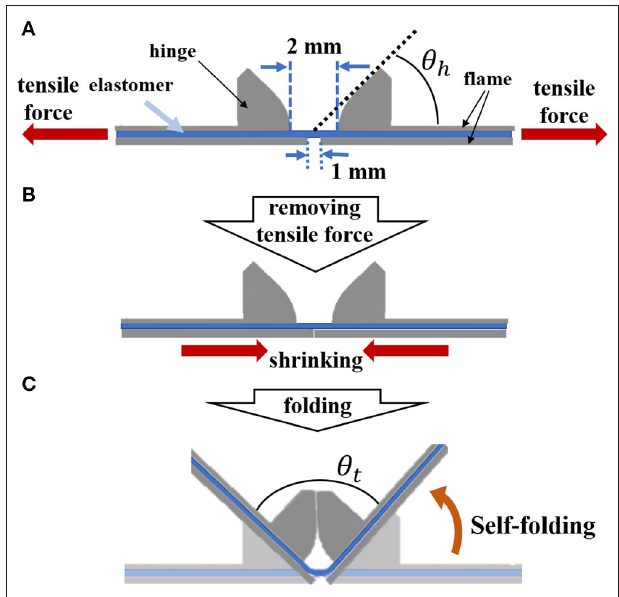
FIGURE 1 | Mechanism of forming a 3D structure. (A) Attach two hinged and non-hinged frames to both sides of the pre-stretched elastomer. (B) When the tensile force is removed, the elastomer shrinks and the non-hinge frames collide, which has a shorter distance between the frames. (C) The contraction force of the elastomer produces a 3D structure, and the folding angle θ t is determined by the angle θ h of the hinge.